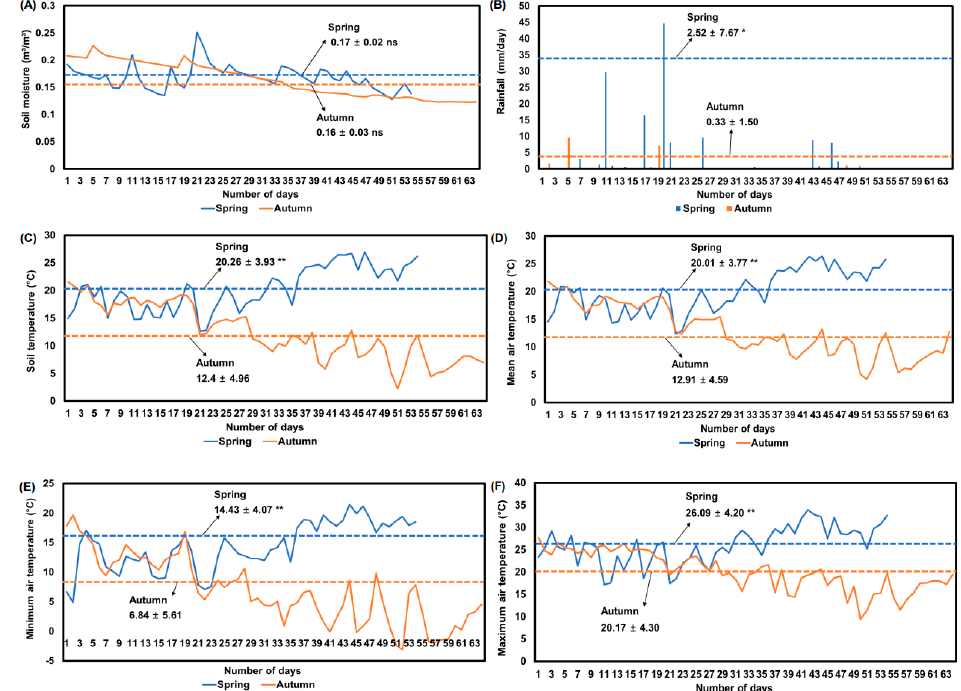
Figure 1. Seasonal average soil moisture ( A ); rainfall ( B ); soil temperature ( C ); mean air temperature ( D ); minimum air temperature ( E ); and maximum air temperature ( F ) during spring and autumn plantings for radish ( Raphanus sativus L.) in 2020. Blue (spring) and orange (autumn) dashed line indicated average value of each environment condition. Ns and asterisks (* and **) next to mean and standard deviation values (dashed blue and orange line) indicate significant differences between spring and autumn by t -test at p > 0.05, p < 0.01, and p < 0.001, respectively.